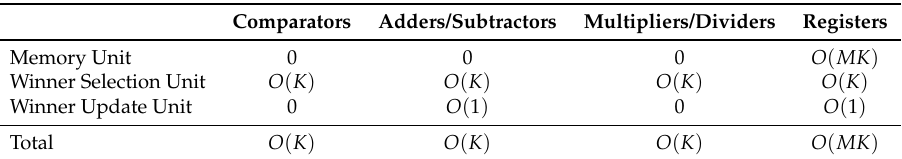
Table 1. The area complexities of the training and classification circuit.